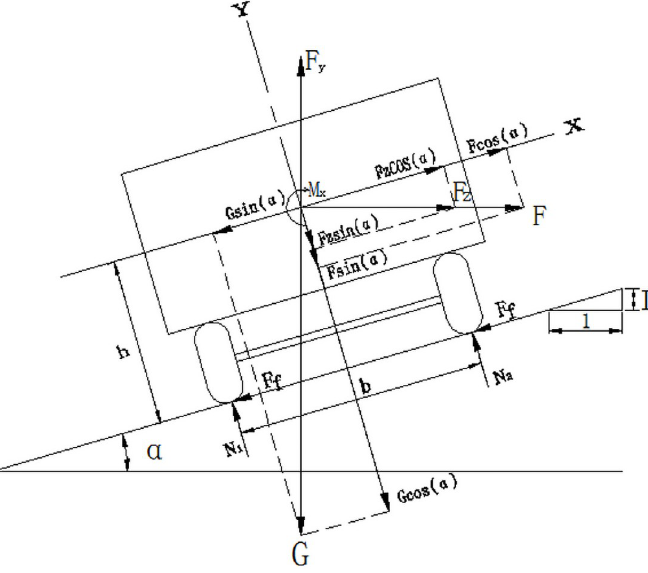
Fig 1. Stress analysis of bus in curve sections. F f —Road friction (KN); N 1 , N 2 —Road support force